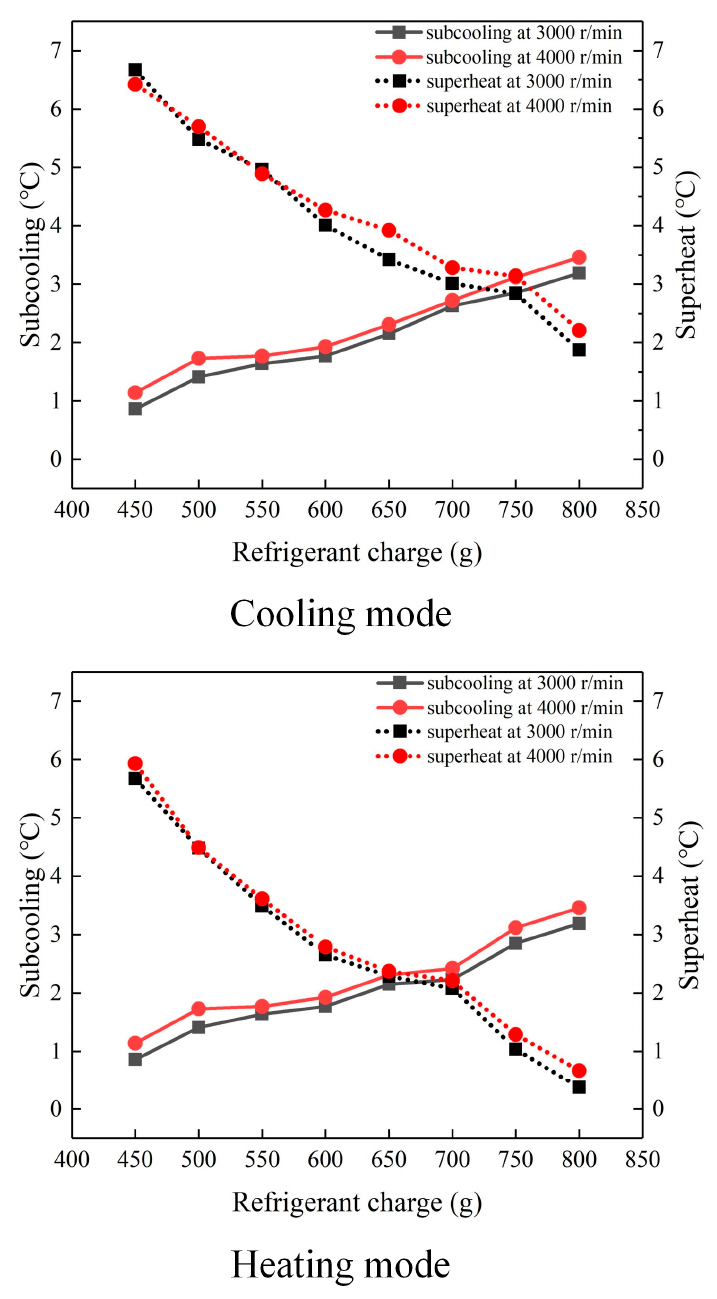
Figure 10. Subcooling and superheating variations with refrigerant charge .